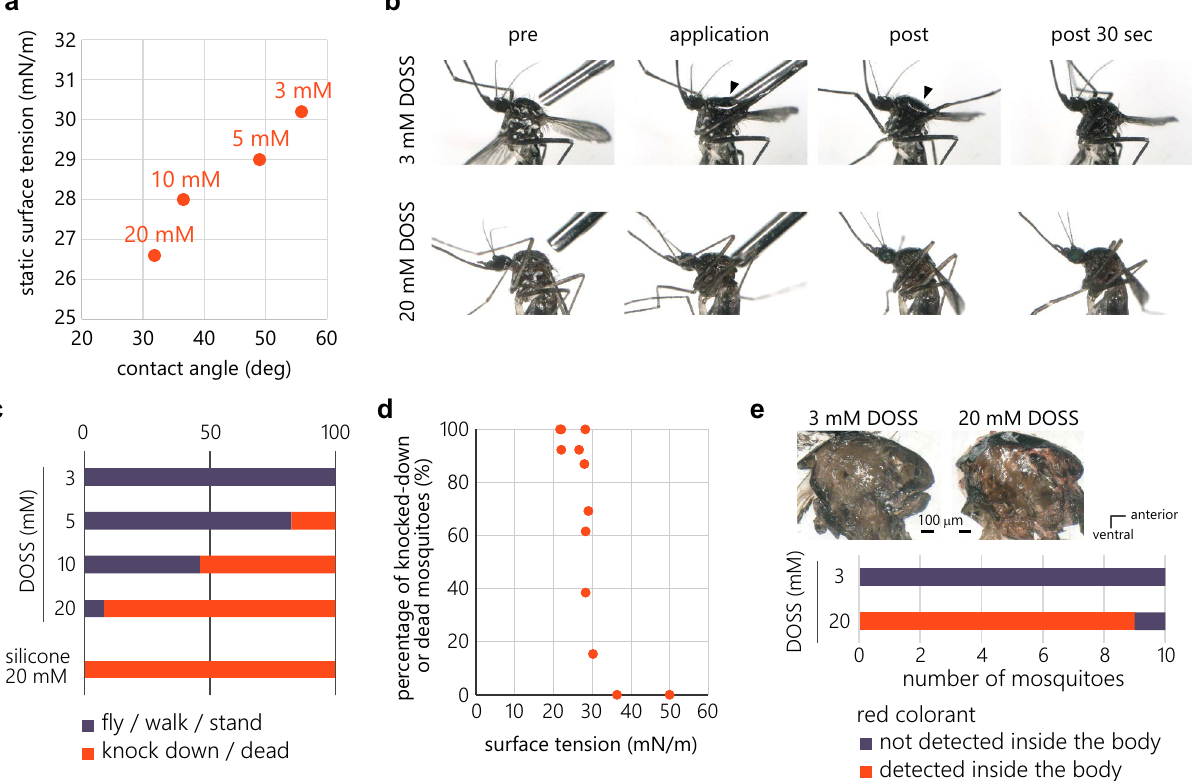
Figure 3. Solutions with lower surface tension can knock down or even kill mosquitoes. ( a ) The relationship between the contact angle on mosquito body and surface tension of 3, 5, 10, 20 mM DOSS. ( b ) Snapshots of movies showing wetting behavior of DOSS solutions on mosquitoes. Each photo shows solutions and mosquitoes before (pre), during (application), immediately after (post) and 30 s after the application of 3 and 20 mM DOSS (post 30 s). Droplets were observable only when 3 mM DOSS was applied (filled arrowheads). Application of 20 mM DOSS did not form a drop as the solution spread rapidly over the surface. ( c ) Mosquito behavior after the application of 3, 5, 10, 20 mM DOSS and silicone. 130 nL of each solution was applied on the mosquito’s thorax using a microliter syringe. Blue represents the percentage of mosquitoes that were able to fly, walk or stand 60 min after the application of each solution, and red represents the percentage of mosquitoes that were knocked down or dead. ( d ) Correlation between surface tension of solutions and the percentage of knocked-down or dead mosquitoes. Each dot indicates one of the following solutions; 3, 5, 10, 20 mM DOSS, 5, 10, 20 mM E108, 5, 10, 20 mM silicone, 20 mM E150, and 20 mM alkyl benzyl dimethyl ammonium chlorides. ( e ) Entry of 20 mM DOSS solution into the mosquito’s body. Red colorant was detected inside the body following the application of 20 mM but not 3 mM DOSS containing red colorant on the mosquito’s